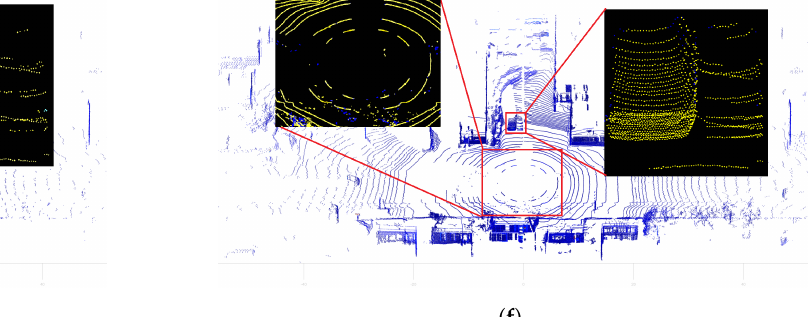
Figure 7. Comparing performance of DROR, DSOR, DDIOR, and our proposed filter on the fifth scan of Sequence 14 from the WADS under light snowfall conditions. The black background visualize the zoom region from the red box. Blue points in zoom regions from AGDOR represent the object points that are retained after applying our filter. ( a ) Raw data. ( b ) Ground truth. ( c ) DSOR. ( d ) DROR. ( e ) DDIOR. ( f ) AGDOR.